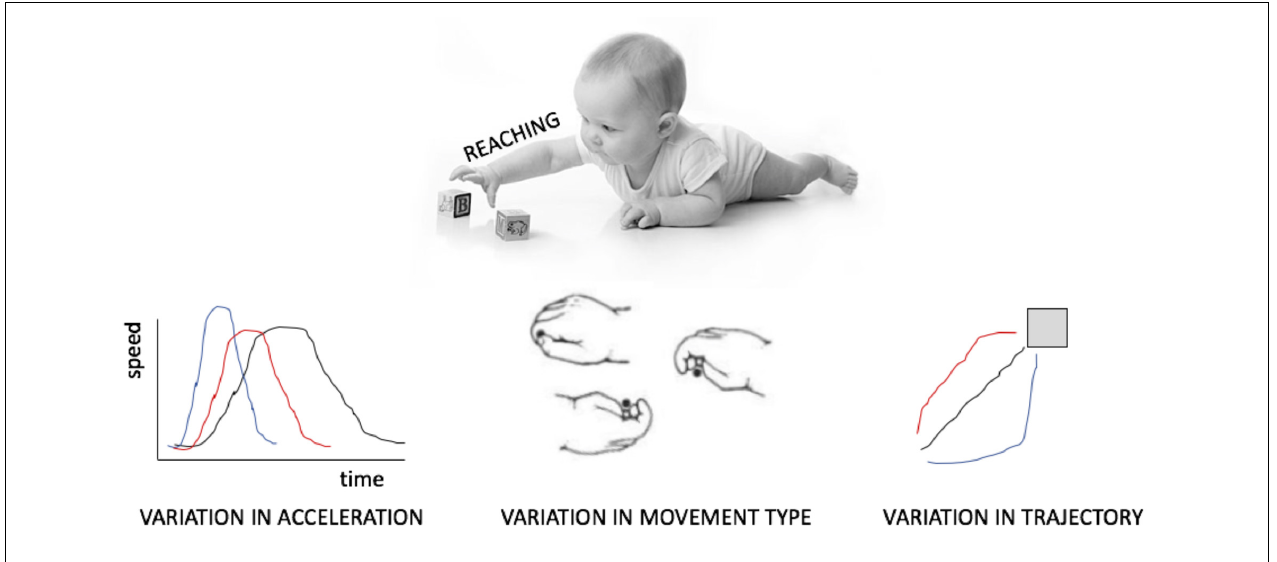
FIGURE 1 | Different manifestations of variability in motor output, here exemplified for reaching and